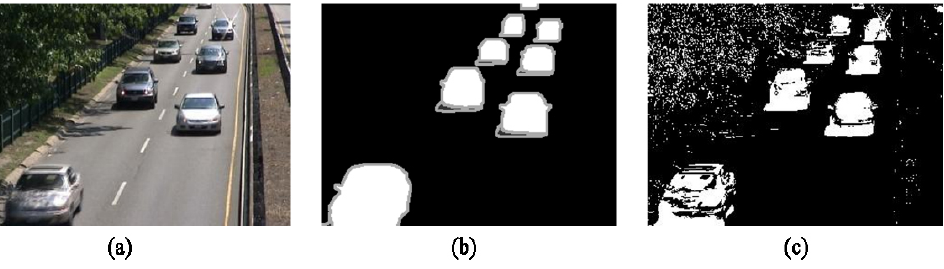
Figure 4. Comparison of the detection results of the original codebook algorithm: ( a ) Color image; ( b ) True value diagram; ( c ) Detection result diagram of the original codebook